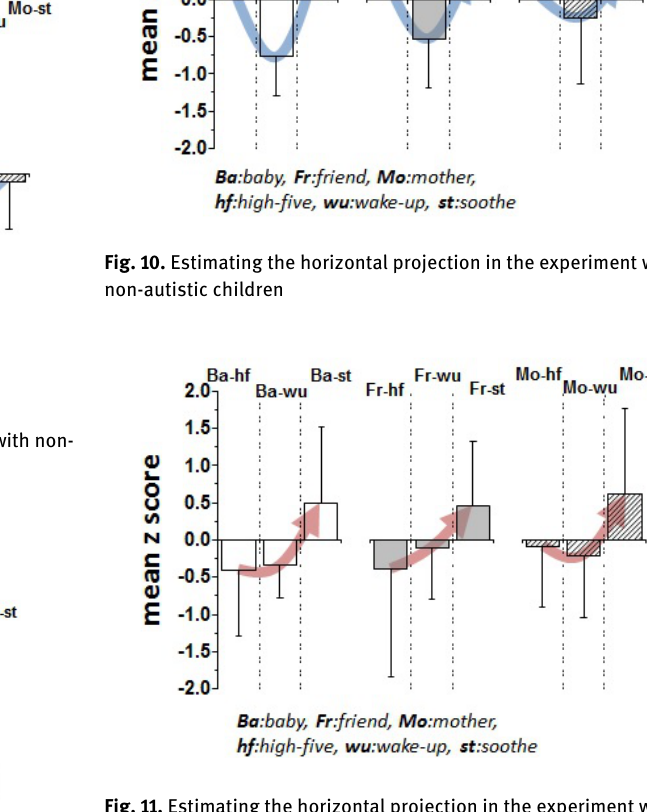
Fig. 11. Estimating the horizontal projection in the experiment with autistic